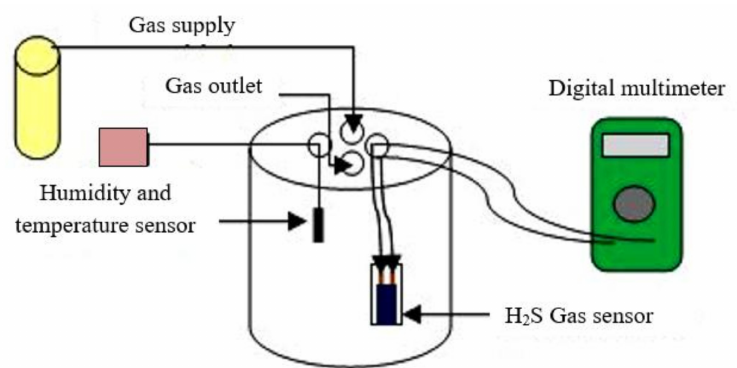
Figure 13. Schematic for set-up used for H 2 S gas